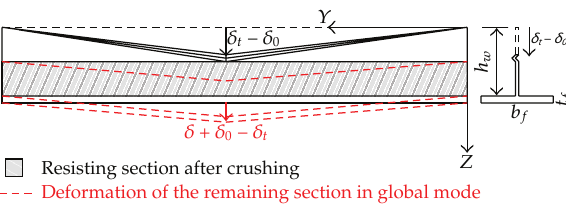
Figure 25: Resistance in the global mode of a transversal frame already crushed during the local mode.